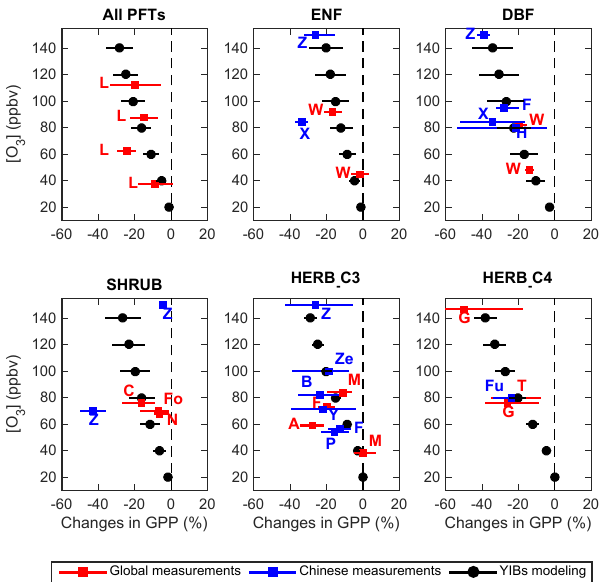
1012 Figure 5. Comparison of predicted changes in summer GPP by O 3 with measurements. 1013 Figure 5. Comparison of predicted changes in summer GPP by Simulations are performed using the offline YIBs vegetation model (Table S2) and 1014 O 3 with measurements. Simulations are performed using the offline averaged for all grid squares over China weighted by the area of a specific PFT. Black 1015 YIBs vegetation model (Table S2) and averaged for all grid squares points show the simulated mean reductions with error bars indicating damage range from 1016 over China weighted by the area of a specific PFT. Black points low to high O 3 sensitivity. Solid squares with error bars show the results (mean plus 1017 show the simulated mean reductions with error bars indicating dam- uncertainty) based on measurements reported in the literature (Table S1). Experiments 1018 age range from low to high O 3 sensitivity. Solid squares with error performed for vegetation types in China are denoted with blue symbols. The author 1019 bars show the results (mean plus uncertainty) based on measure- initials are indicated for the corresponding studies. 1020 ments reported in the literature (Table S1). Experiments performed for vegetation types in China are denoted by blue symbols. The au- thor initials are indicated for the corresponding studies.